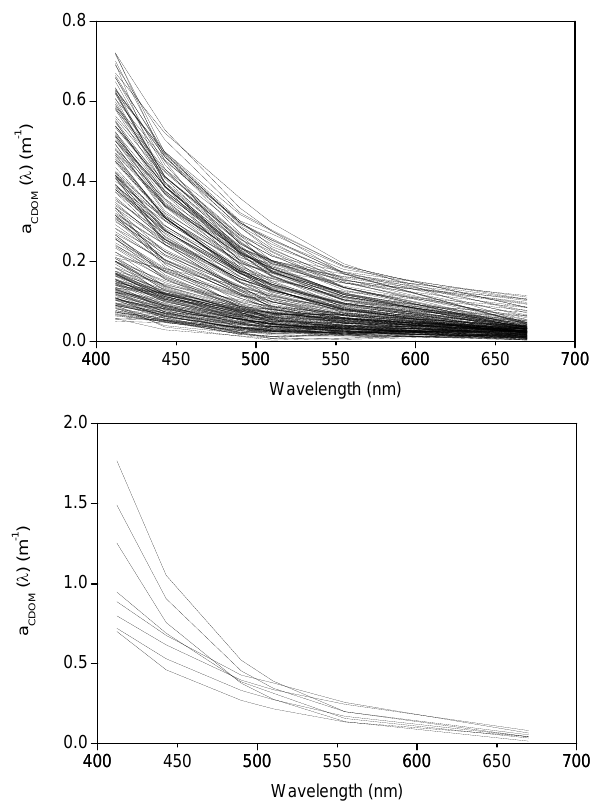
Fig. 2. Spectral variations in the absorption coefficient of coloured dissolved organic matter (a CDOM ( λ ), m - 1 )) in ECS, YS and KSS waters (N=470). Top panel is from the ECS, YS and also KSS and bottom panel is from the KSS.